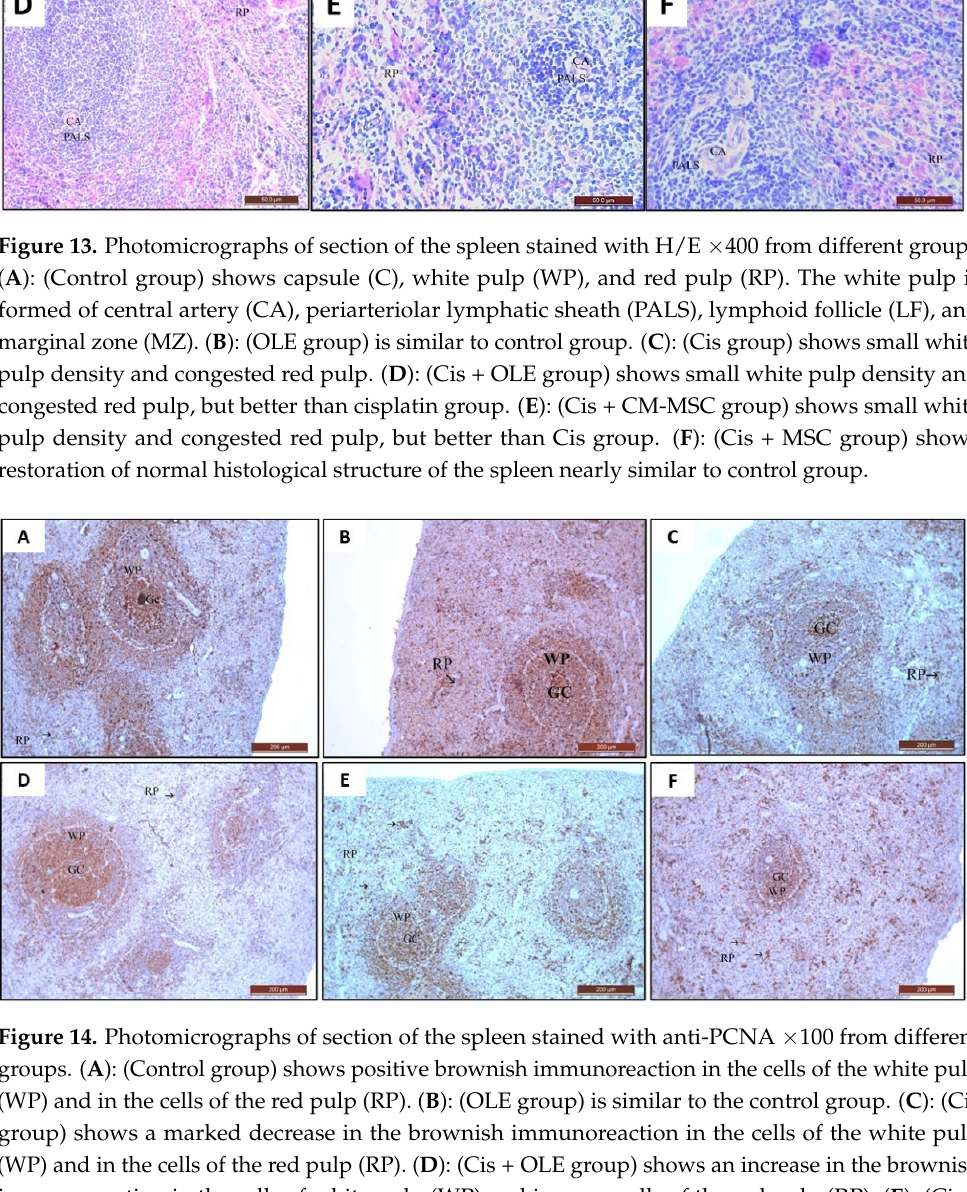
immunoreaction in the cells of white pulp (WP) and in some cells of the red pulp (RP). ( E ): (Cis + CM-MSC group) shows increased brownish immunoreaction in the cells of the white pulp and in